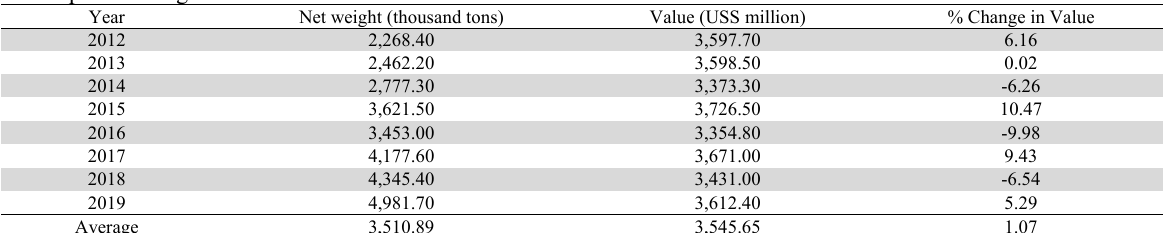
Labor Absorption (Million people)